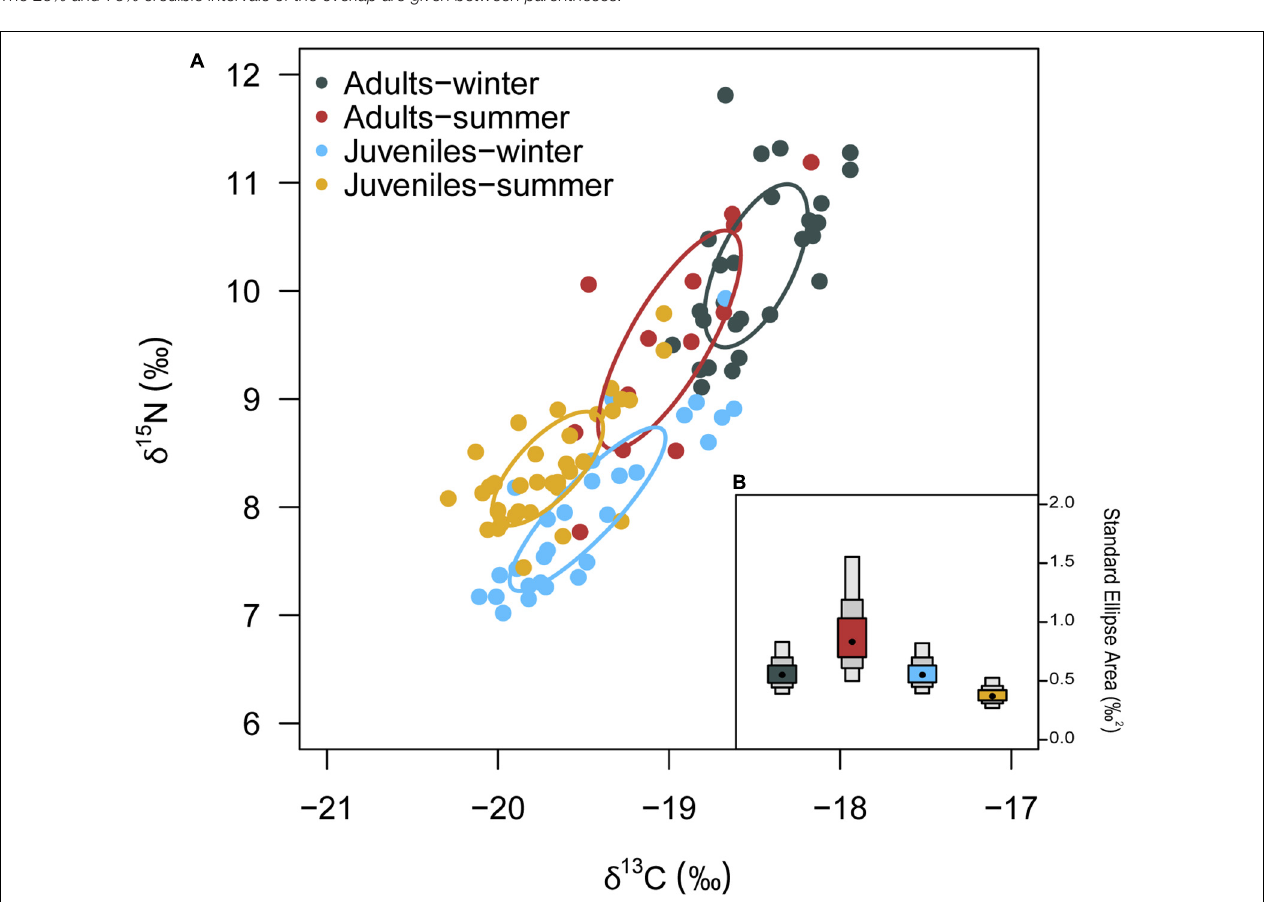
FIGURE 4 | (A) δ 13 C and δ 15 N values and corrected Standard Ellipses Area (SEAc) for European hake by season and stage. (B) Bayesian standard ellipses area (SEA B ) for each groups. Density plots represent the 95, 75 and 50% credibility intervals of SEA B